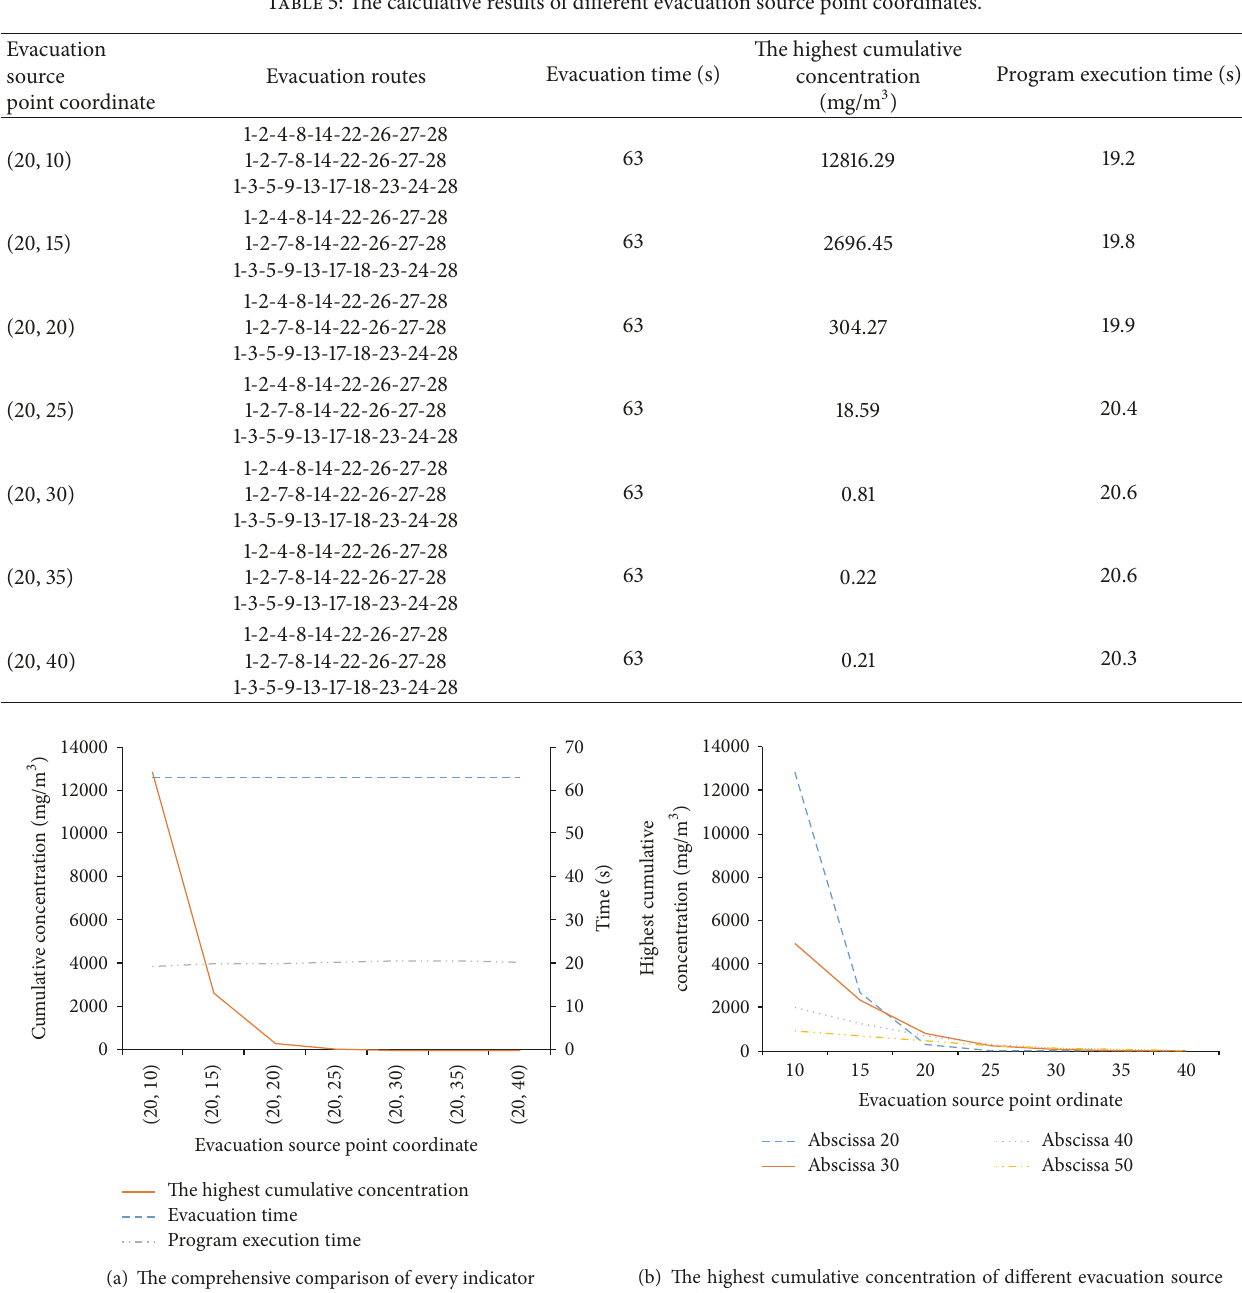
Table 5: The calculative results of different evacuation source point coordinates.